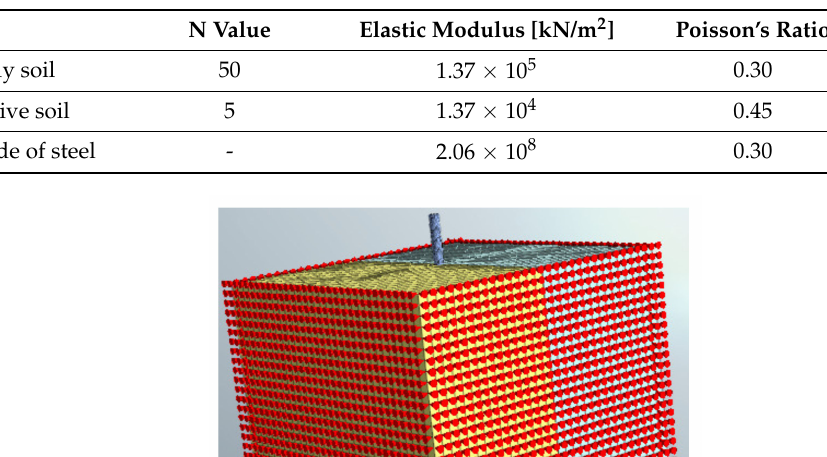
Figure 4. Analysis models applied in this study. Table 1. Ground parameters set in the three-dimensional linear elastic analysis.